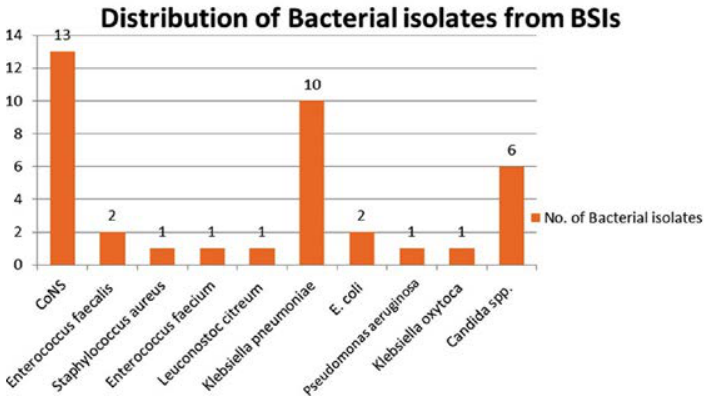
Fig. 1. Distribution of bacterial pathogens among BSIs in patients admitted to ICUs in 2016 & 2017